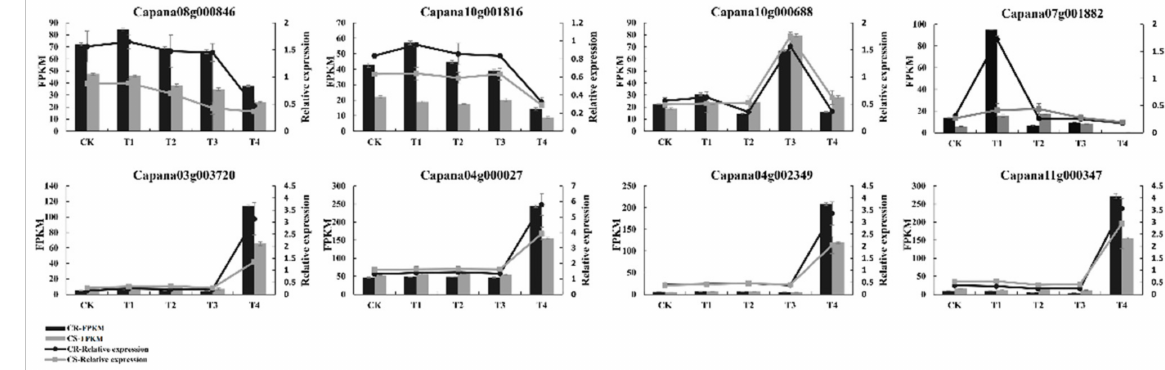
Figure 10. qRT-PCR analyses of eight